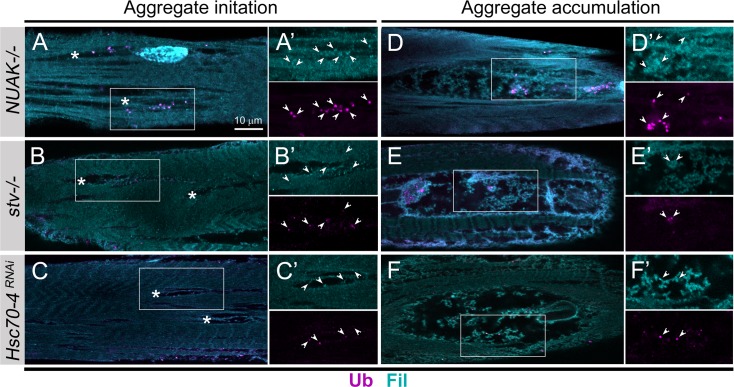
Ub distribution changes during aggregate accumulation.(A-F) Fil (blue) and Ub (purple) immunostaining in L3 muscles in the early (A-C’) or late (D-F’) stages of aggregate accumulation. A decrease in NUAK (A,A’), Stv (B,B’), or Hsc70-4 (C,C’) results in small regions of muscle tissue that begin to accumulate puncta decorated with Fil and Ub puncta (white indented arrowheads). In large areas of aggregate accumulation in NUAK-/- (D,D’) and stv-/- (E,E’) mutants or upon Hsc70-4 RNAi knockdown (F,F’), the co-localization of Ub(+) puncta with Fil protein (white indented arrowheads) is decreased. The white boxed regions in A-F are enlarged in A—F’.